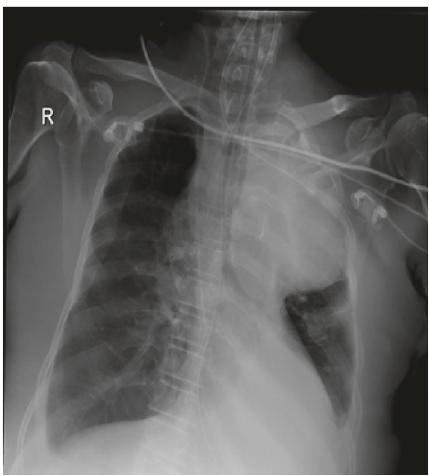
Figure 1: Chest X-ray shows left mediastinal mass.